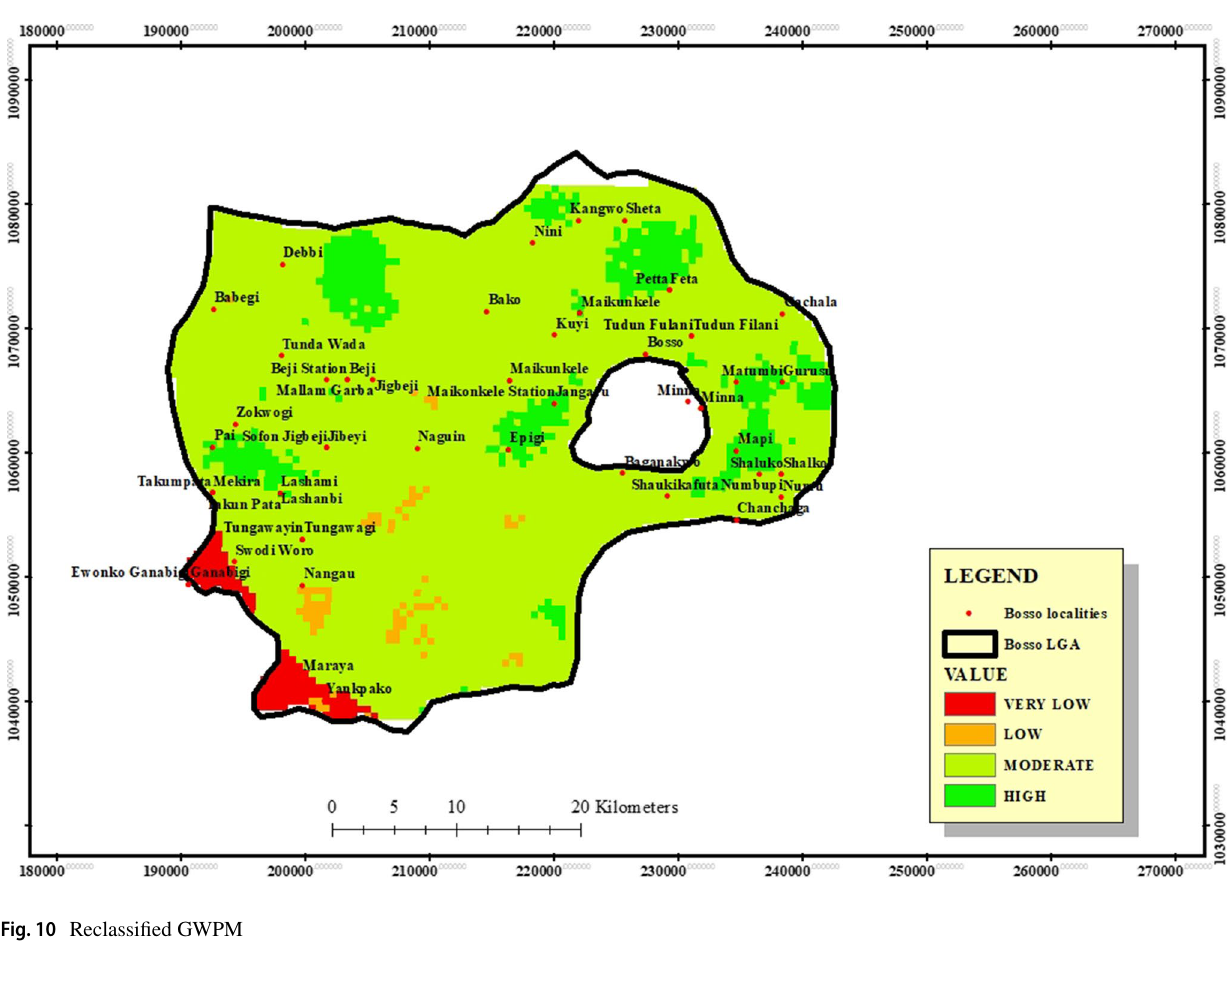
Table 8 GWP zoning of Bosso localities in Bosso local government